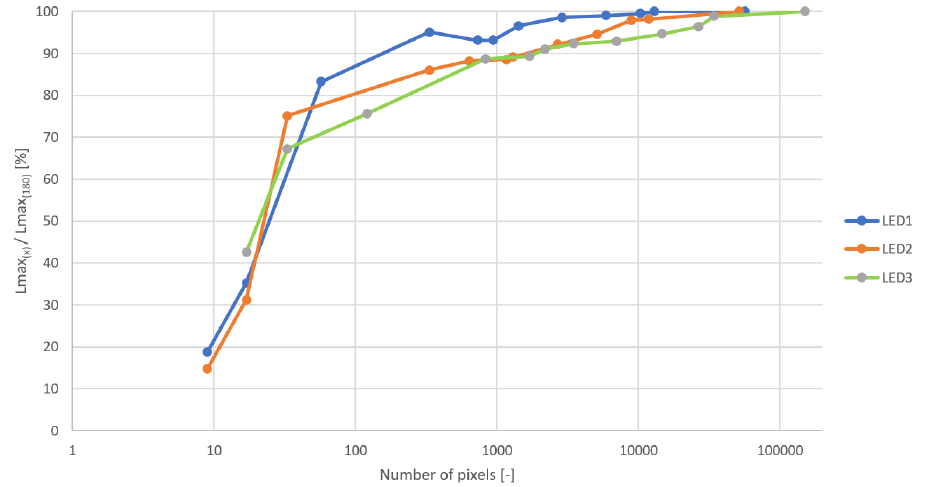
Figure 8. The relative maximum luminance (related to Lmax for 180 mm) for LED1. LED2 and LED3 as the function of pixel number.